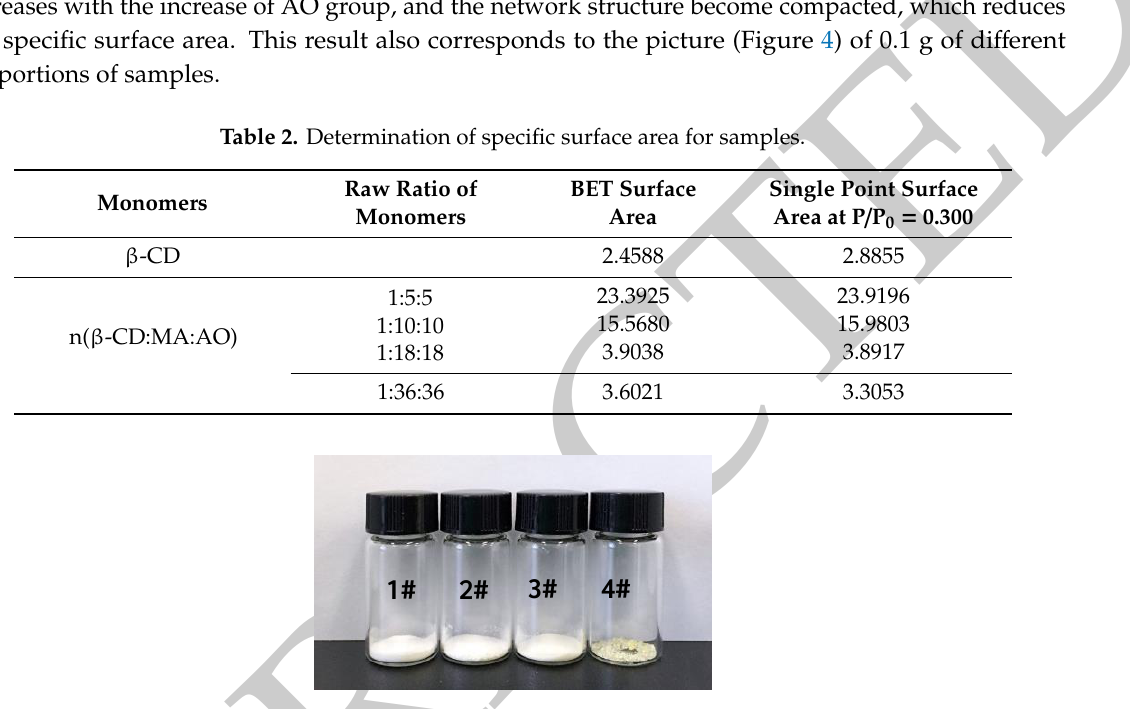
Figure 4. Images of 0.1 g of different proportions of samples.